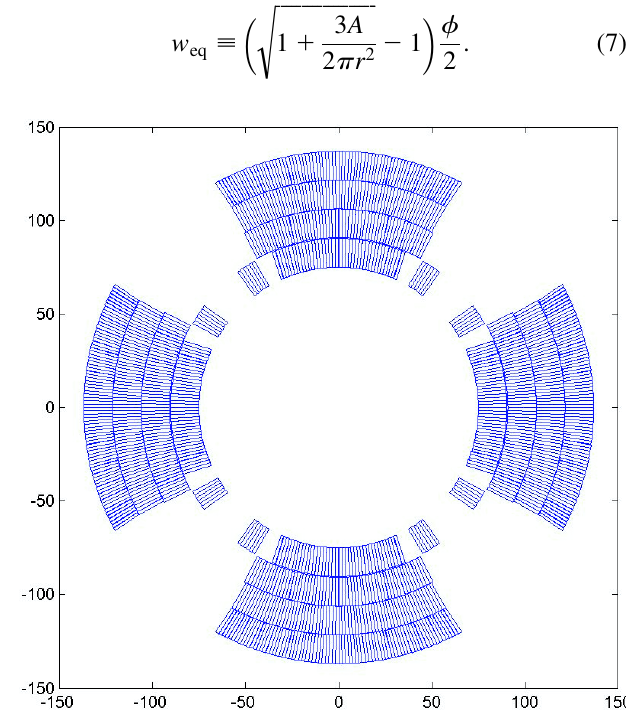
FIG. 5. (Color) Coil layout of a quadrupole with 50 mm aper- ture.